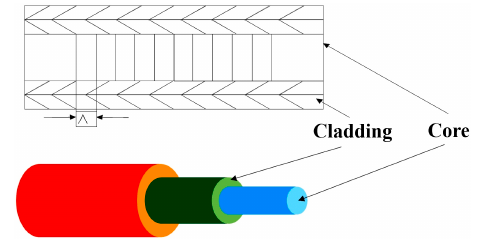
Figure 1. Optical fiber structure.